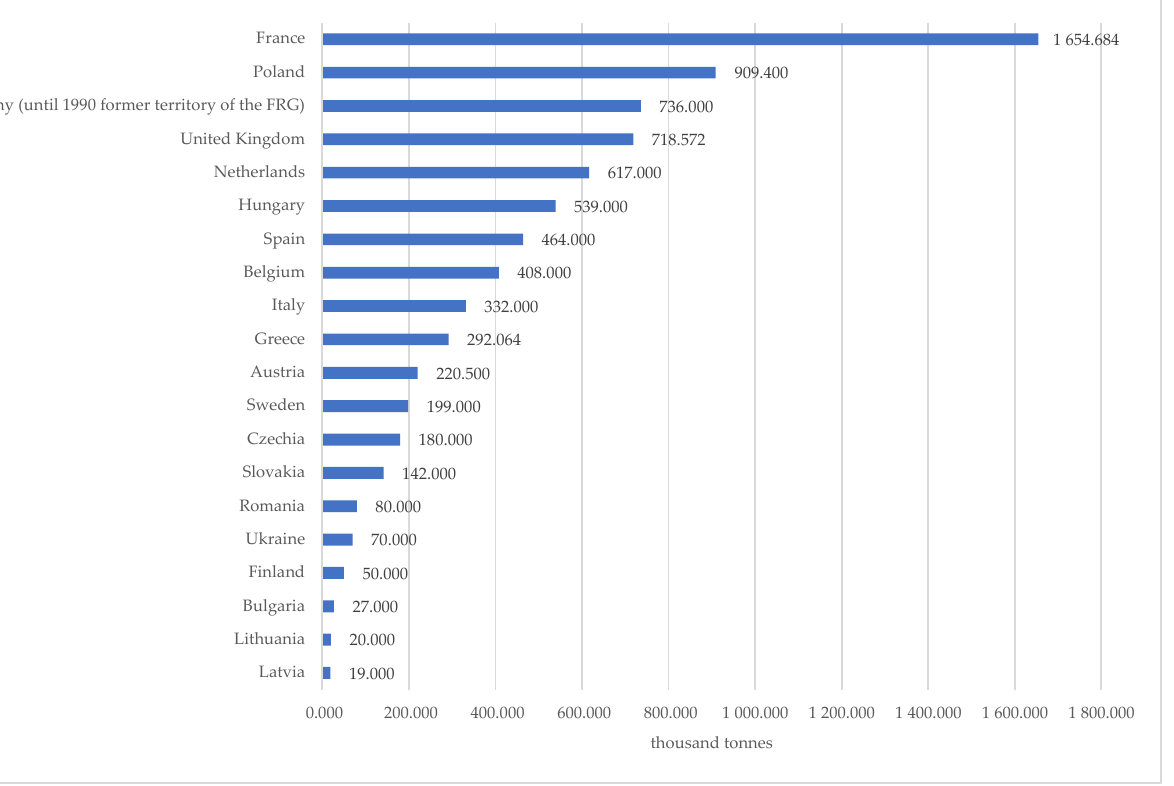
Figure 3. Pure biodiesel production in EU in 2019 (thousand tons). Source: own elaboration based on Eurostat data [55].